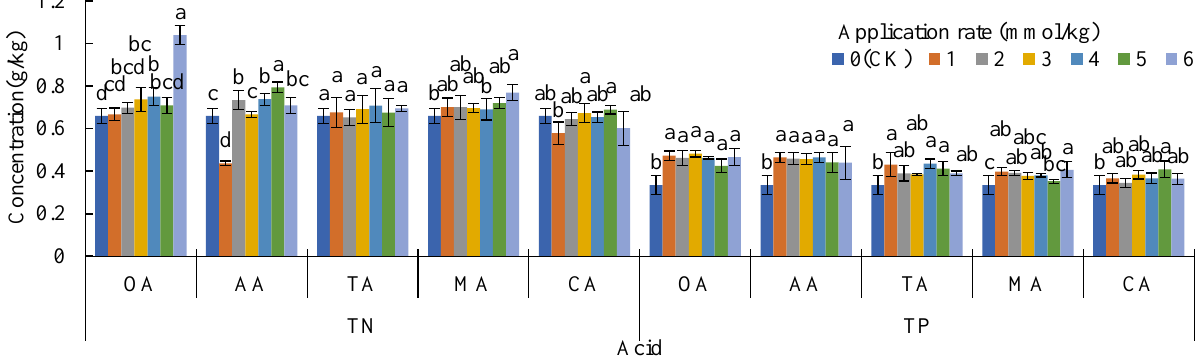
Figure 4. TN and TP in rhizosphere soil under organic treatments and CK; oxalic acid (OA), acetic acid (AA), tartaric acid (TA), malic acid (MA), and citric acid (CA). Different lowercase letters show significant differences for p < 0.05.